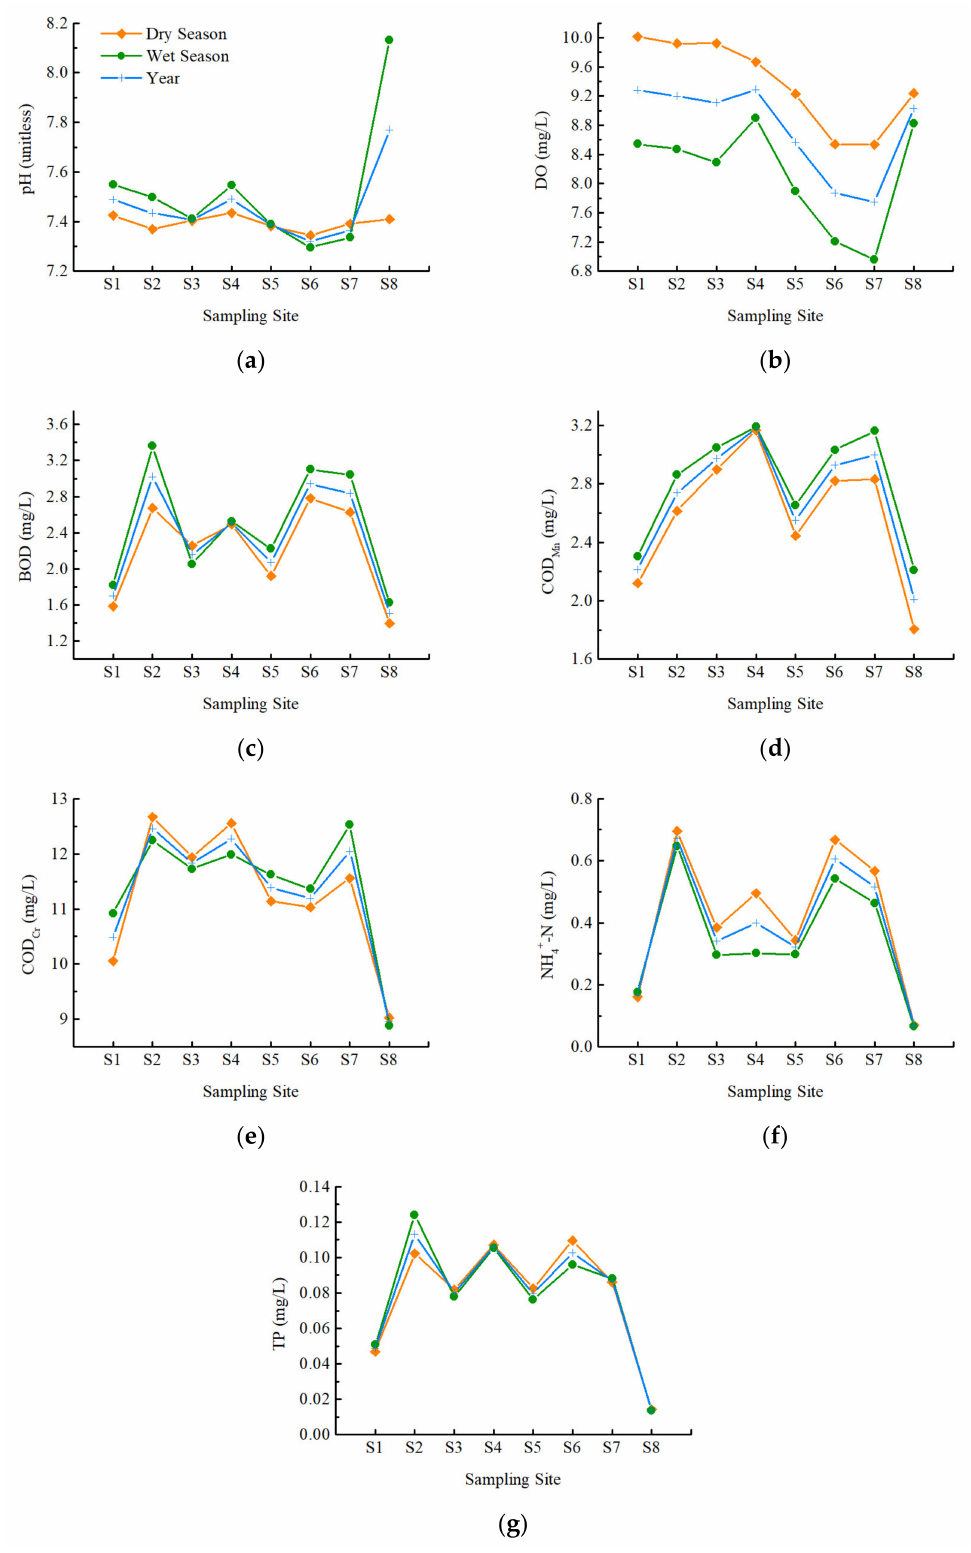
Figure 2. Water quality levels according to years, as well as dry and wet seasons, in each sampling site. ( a ). pH; ( b ). DO; ( c ). BOD; ( d ) COD Mn ; ( e ) COD Cr ; ( f ) NH 4 + -N; ( g